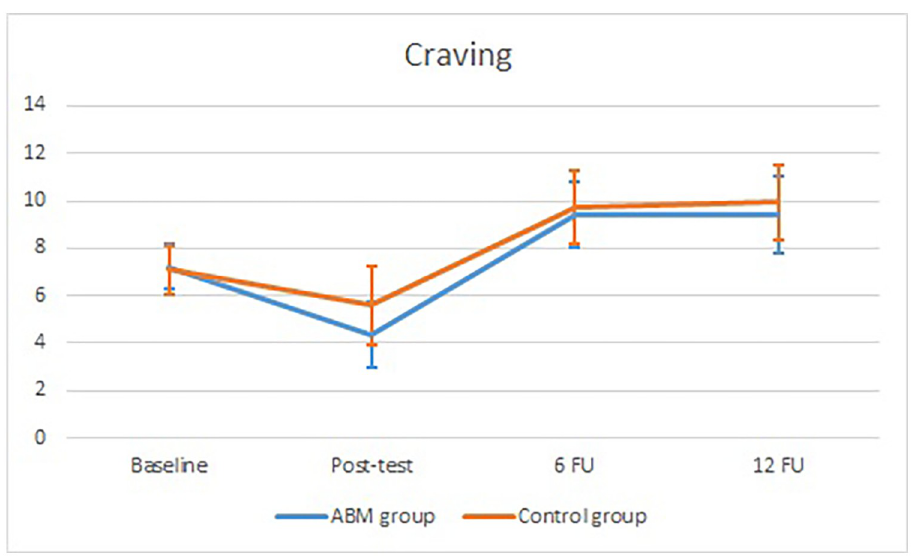
Fig 5. Craving for the ABM group and the control group at baseline, post-test, 6 FU, and 12 FU.